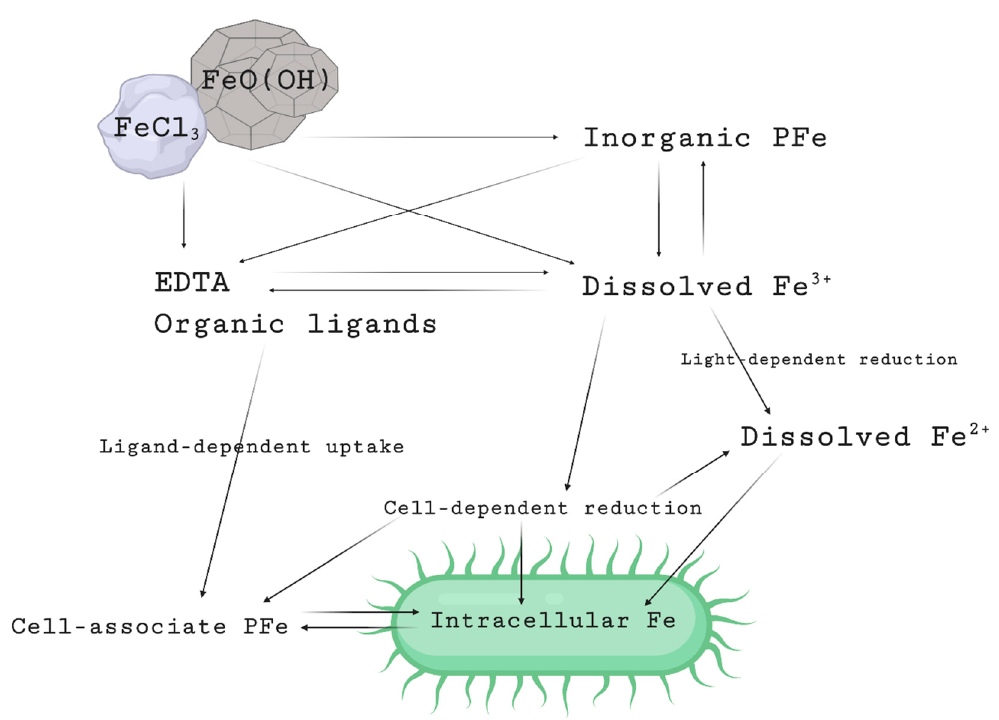
Figure 6. Interactions within an iron pool are complex and often mediated by other constituents within a seawater medium. Iron can be internalized by a cell through a range of mechanisms but usually only after specific modifications from the original iron source.